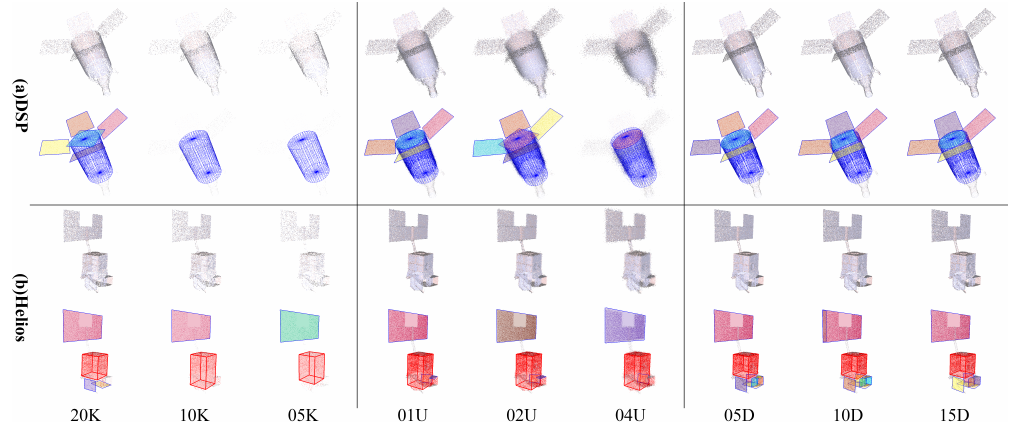
Figure 7. Results of robustness analysis with a single factor. The first grid row is the detection results of spacecraft ( a ) DSP, and the second grid row is the results of ( b ) Helios. From left to right, the grid columns are point clouds with different sample numbers ( **K_00U_00D ), different distance noises ( 50K_**U_00D ) and different direction noises ( 50K_00U_**D ). The top row in each grid displays the origin input point clouds, and the bottom row displays the final results. The cylinders are rendered in blue; patches are rendered in different colors; and cuboids are rendered as red boxes.